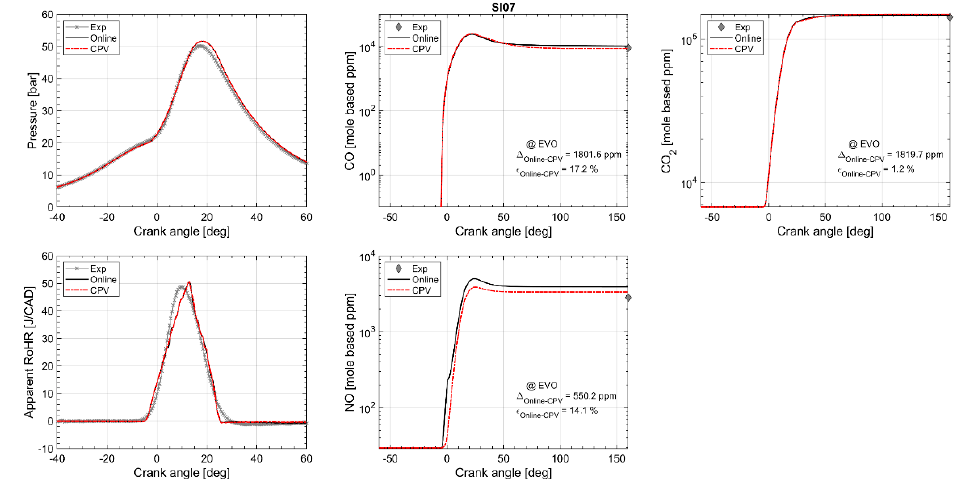
Figure A17. Engine performance and emissions for operating point SI07 (2500 rpm, 10.0 bar IMEP).